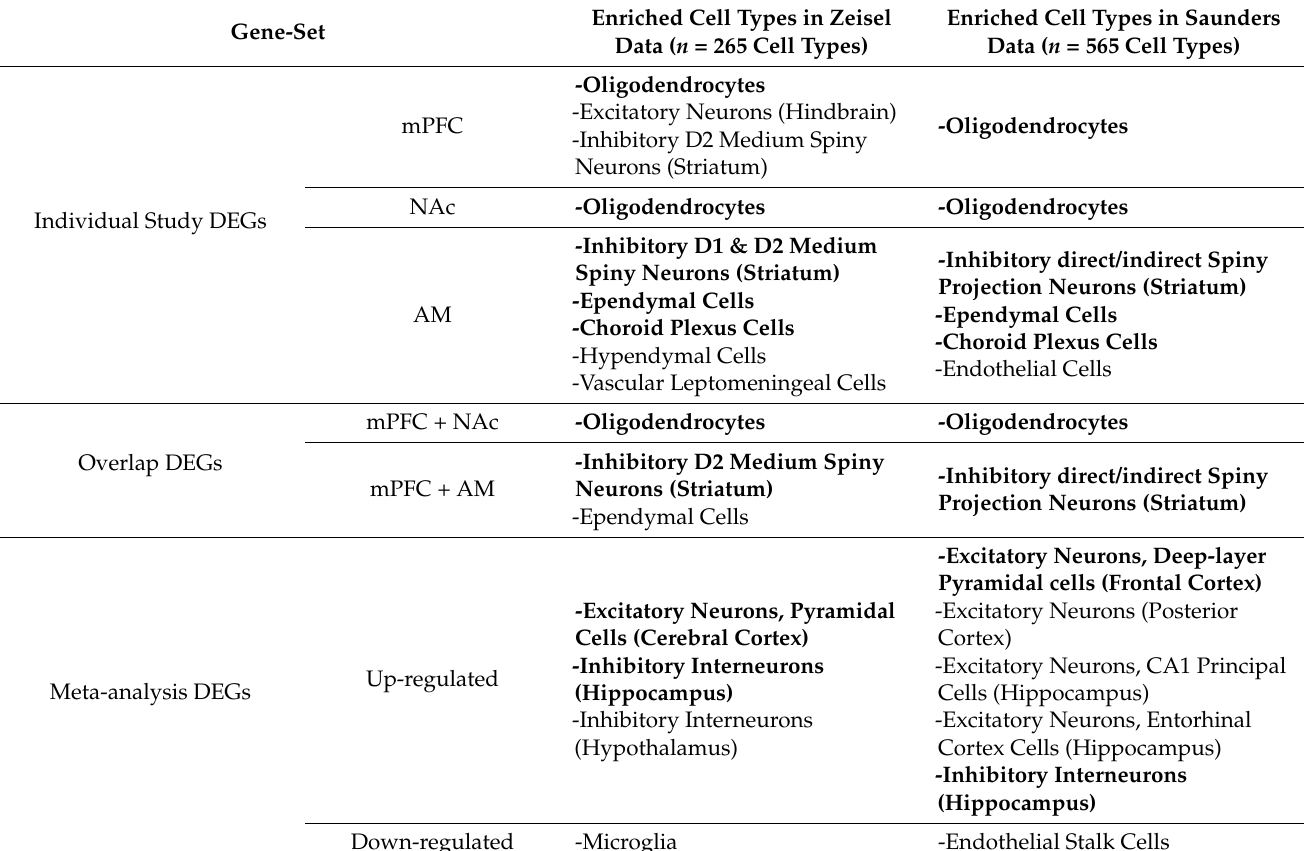
Table 3. Significantly enriched cell types as determined by expression-weighted cell type enrichment (ewce) using single cell gene expression